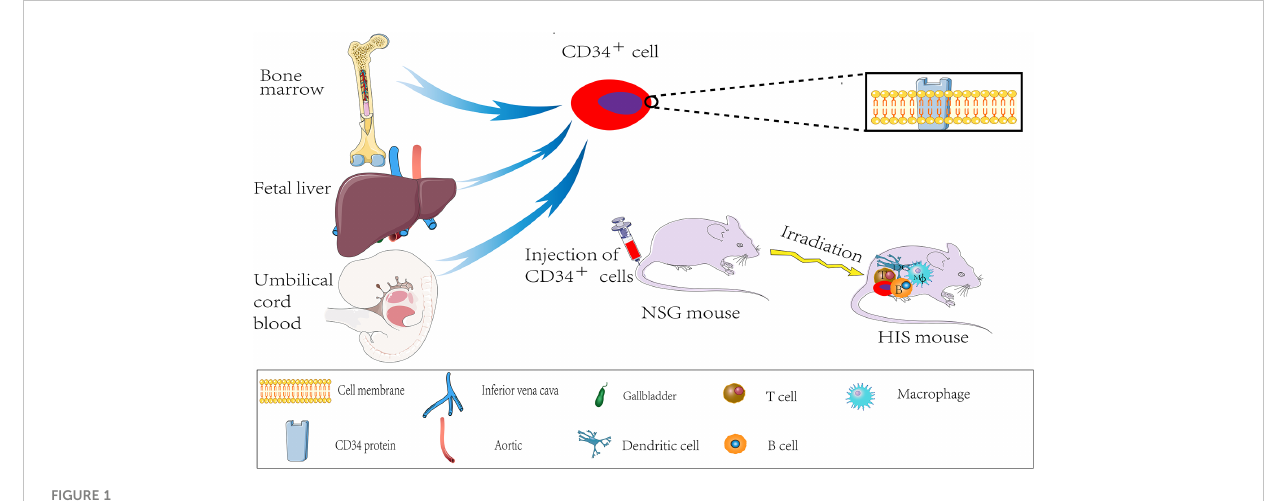
FIGURE 1 HIS mouse production